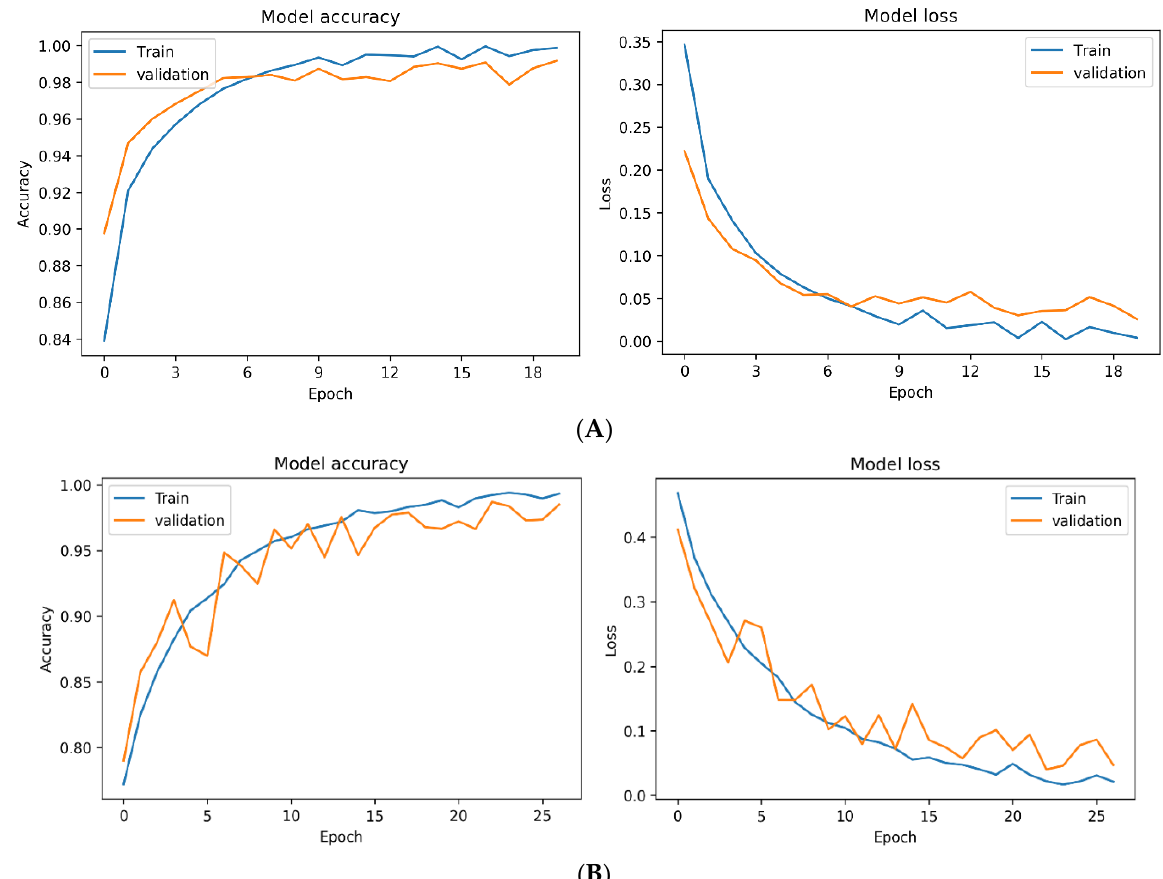
Figure 6. Effect of feature scaling on the accuracy and loss during the training. ( A ) Comparison of training and validation accuracy (left) and loss (right) with the features between − 1 and 1 using accuracy and loss. ( B ) Comparison of training and validation accuracy (left) and loss (right) with the features between 0 and 1 using accuracy and loss.